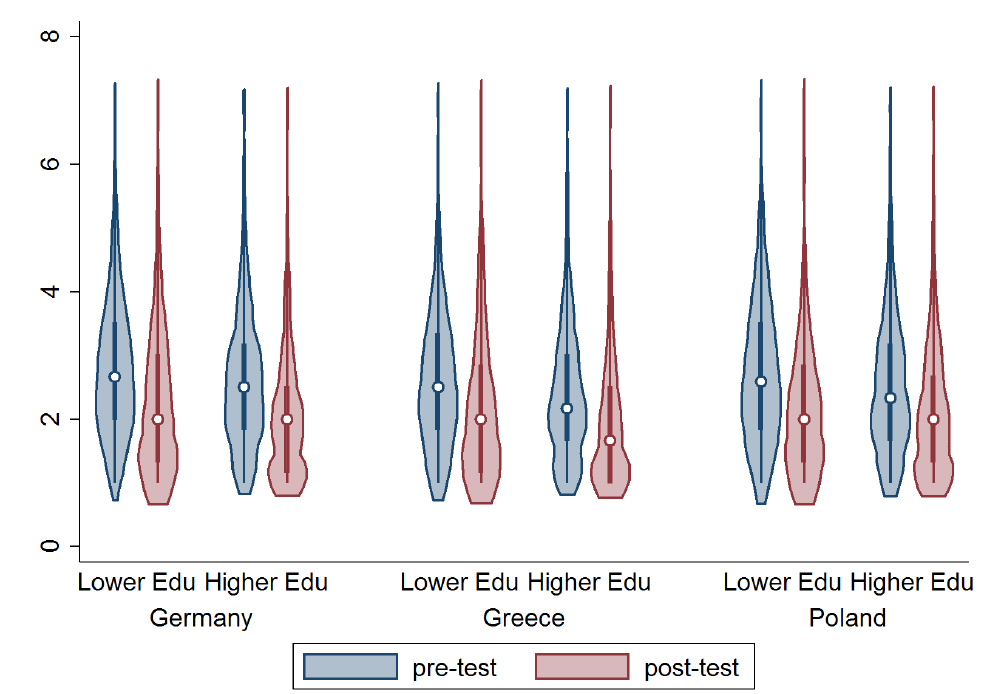
Figure 4. Violin plots for the German, Greek, and Polish versions of the game (pre-and-post-test), by education (lower education = high school or less). The violin shape represents the distribution of the data and the point estimate is the median (with boxplot). All pre-post differences within each country (by education) are statistically significant at the p < 0.001